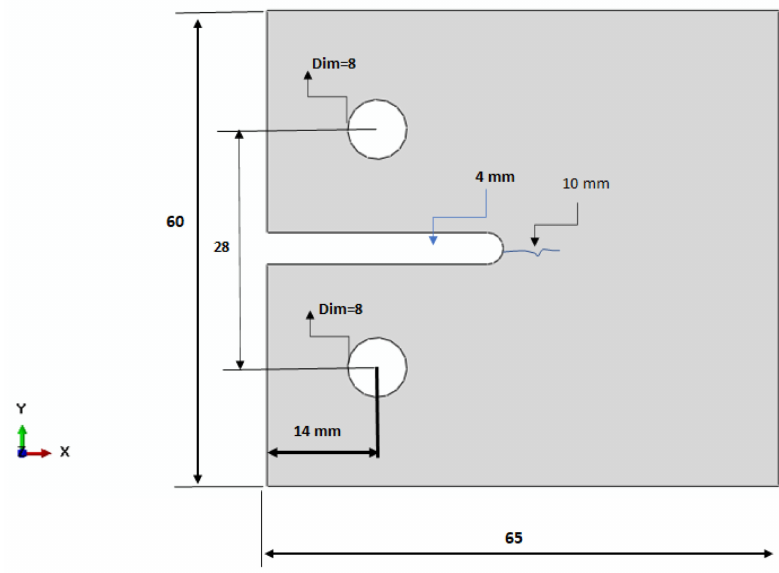
Figure 7. CT test specimen